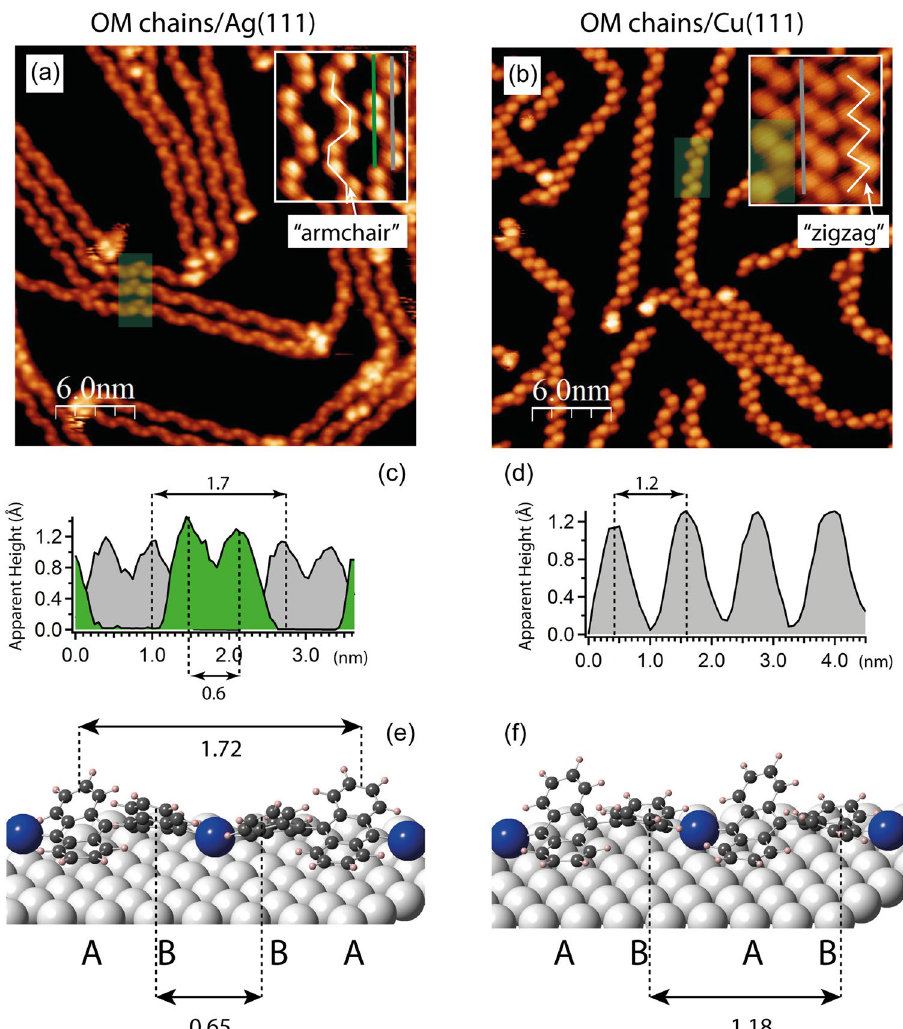
Figure 3. STM images showing OM chains obtained after 30 min annealing of DBBA/Ag(111) at 120 °C ( a ); and OM chains which are formed by DBBA on Cu(111) at RT ( b ). The insets show zoomed-in areas with three OM chains. The “armchair” and “zigzag” chain patterns are highlighted by the white line. The semi- transparent green rectangles highlight sample areas with structural defects in the OM chains. ( c ) and ( d ) are the line profiles taken along the lines of the corresponding color in the insets for OM chain on Ag(111) and Cu(111), accordingly. DFT-optimized models for OM chain on Ag(111) ( e ) and Cu(111) ( f ) are shown, where characteristic distances are marked for comparison with the experimental line profiles. ABBA and ABAB stand for the periodicity characteristic for the “armchair” and “zigzag” OM chains. In the models, the light-grey colored atoms are the substrate atoms, blue colored atoms are the metal adatoms involved in the formation of the OM chain, dark-grey colored atoms are carbon atoms, and light-pink colored atoms are hydrogen atoms. All distances are shown in nm. Tunneling parameters (V S /I T ): ( a ) -1.3 V/300 pA; ( b ) -1.5 V/150